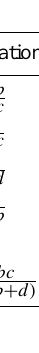
Table 2. Verification indices based on 2 × 2 contingency table. See Table 1 for the definition of a , b , c and d